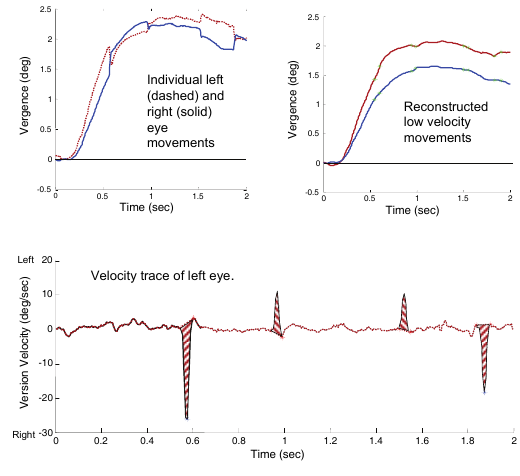
Figure 2 The technique used to separate fast disparity vergence and saccadic components in responses to pure vergence step stimuli. A) Individual eye movements as in Figure 1A and C showing the presence of four saccades. B) The velocity trace of the left eye response (red and black line). The high-velocity contributions have been separated from low-velocity components by linear interpolation between the beginning and end of each saccade (red line ending in ‘*’). The red shaded area shows the estimated high-velocity components. C) An estimate of the slow velocity eye movements was produced by integrating the vergence velocity trace in B (red line) and a similar operation for the right eye. The high-velocity traces were also integrated to estimate saccadic amplitude and saccade-induced vergence enhancement. Under this strategy, saccadic enhancements to fast disparity vergence are recorded as saccadic